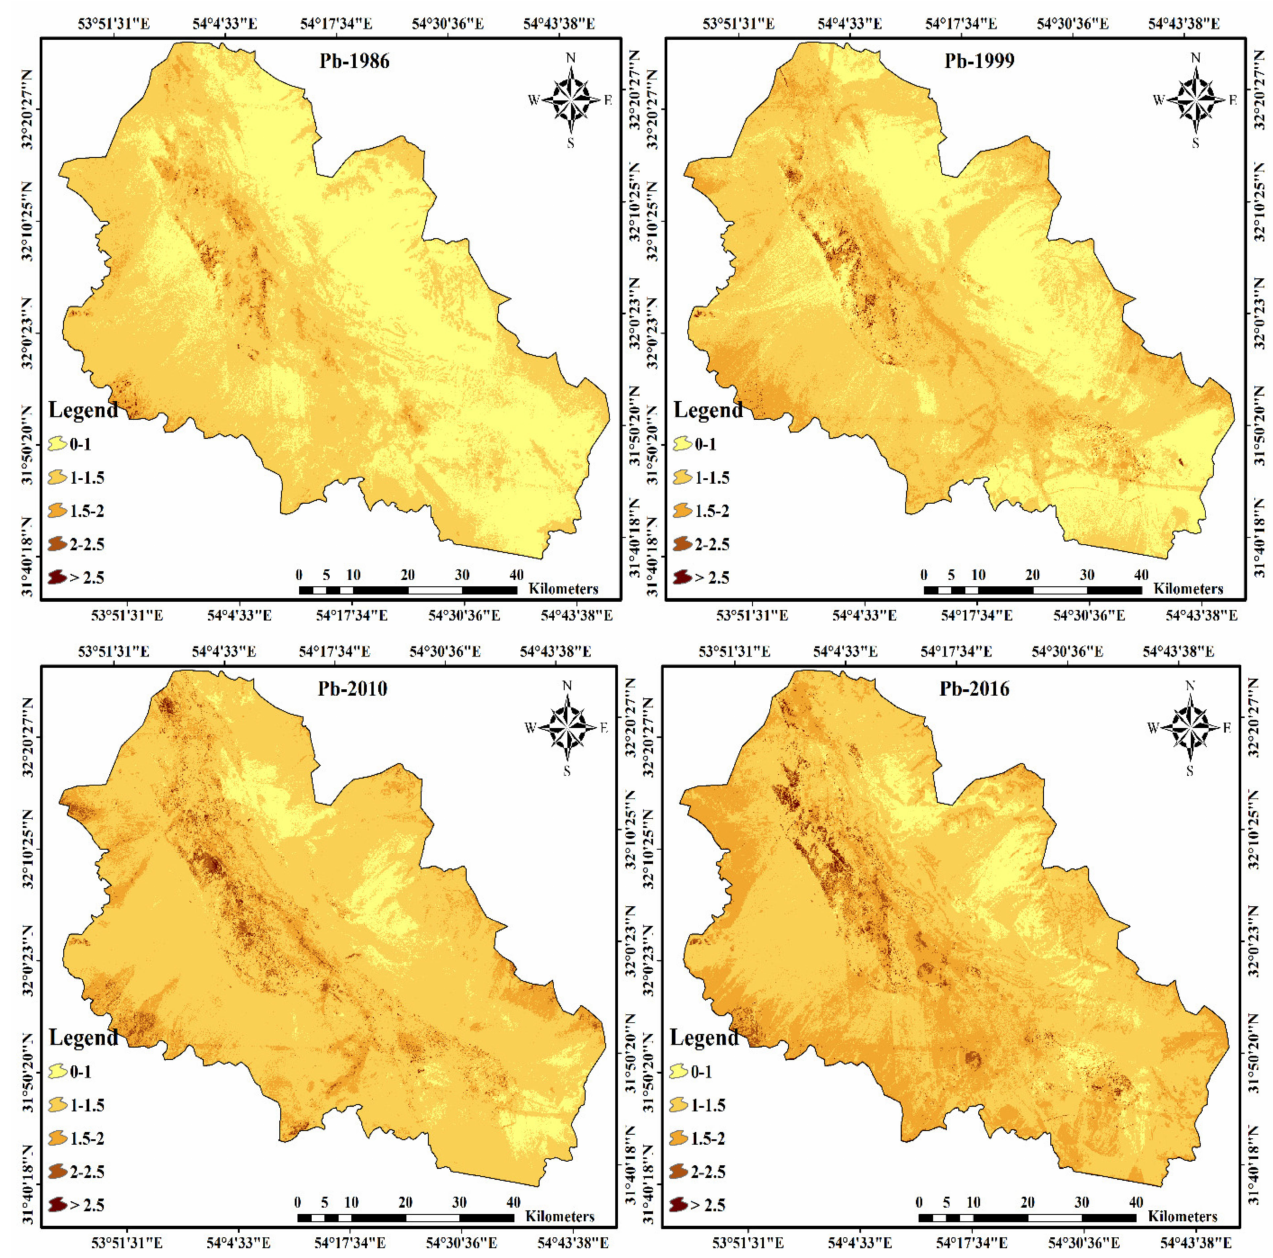
Figure 9. The spatial prediction of Pb (mg/kg − 1 ) for 1986, 1999, 2010, and